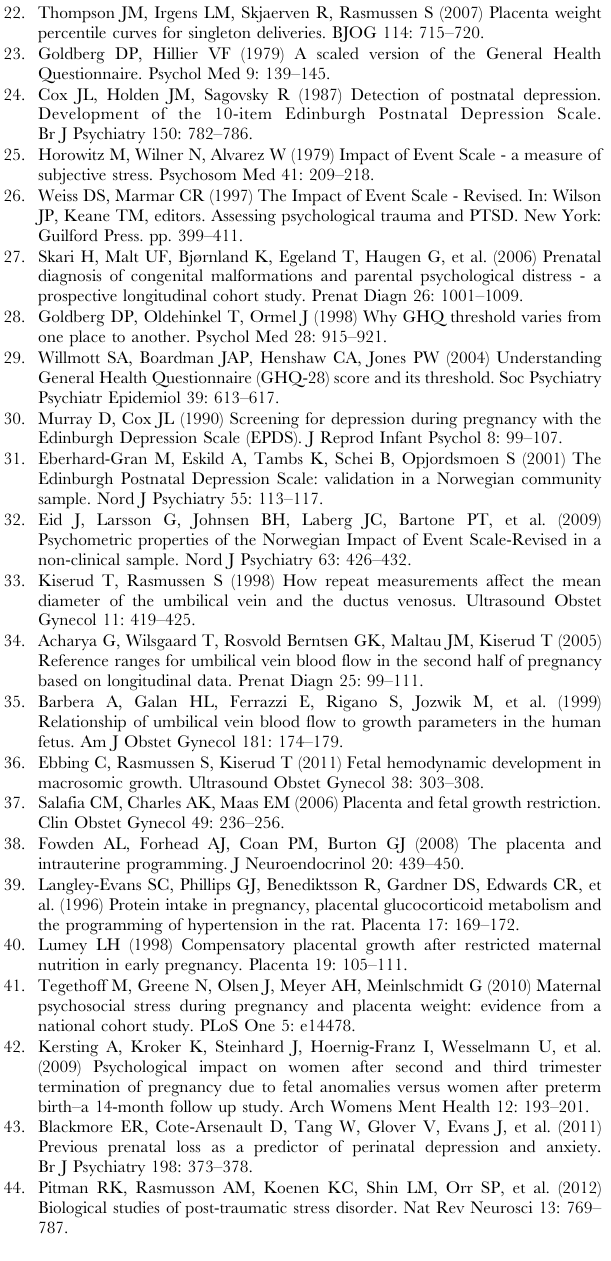
Table S1 Psychological distress scores above clinical cut-off levels at 16 and 30 weeks of gestational age.